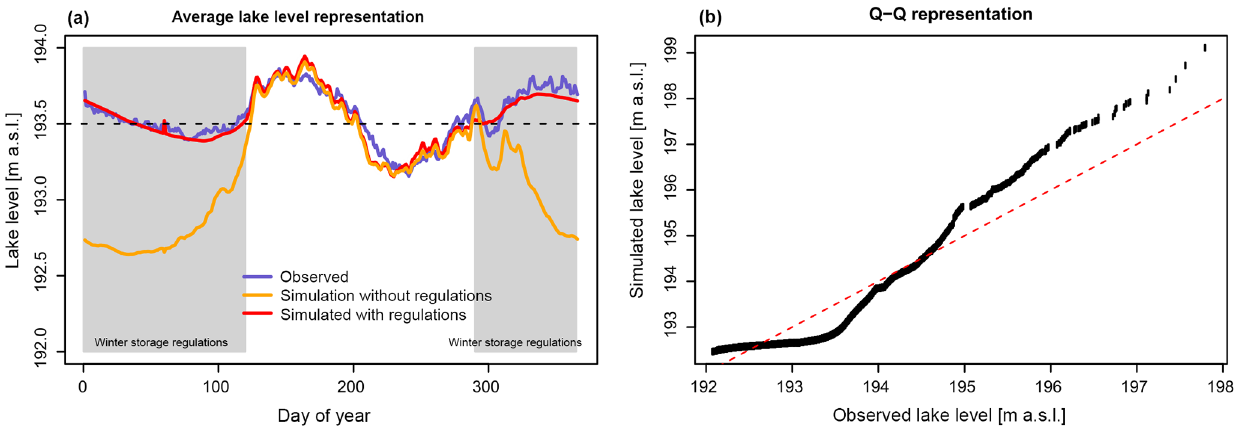
Figure A1. Validation of the hydrological model performance by means of (a) long-term average (1960–2010) and (b) daily value-based Q–Q representation, indicating a fair model performance with the tendency to overestimate higher lake levels. In panel (a) , we show the model representation assuming a simple winter storage regulation (red